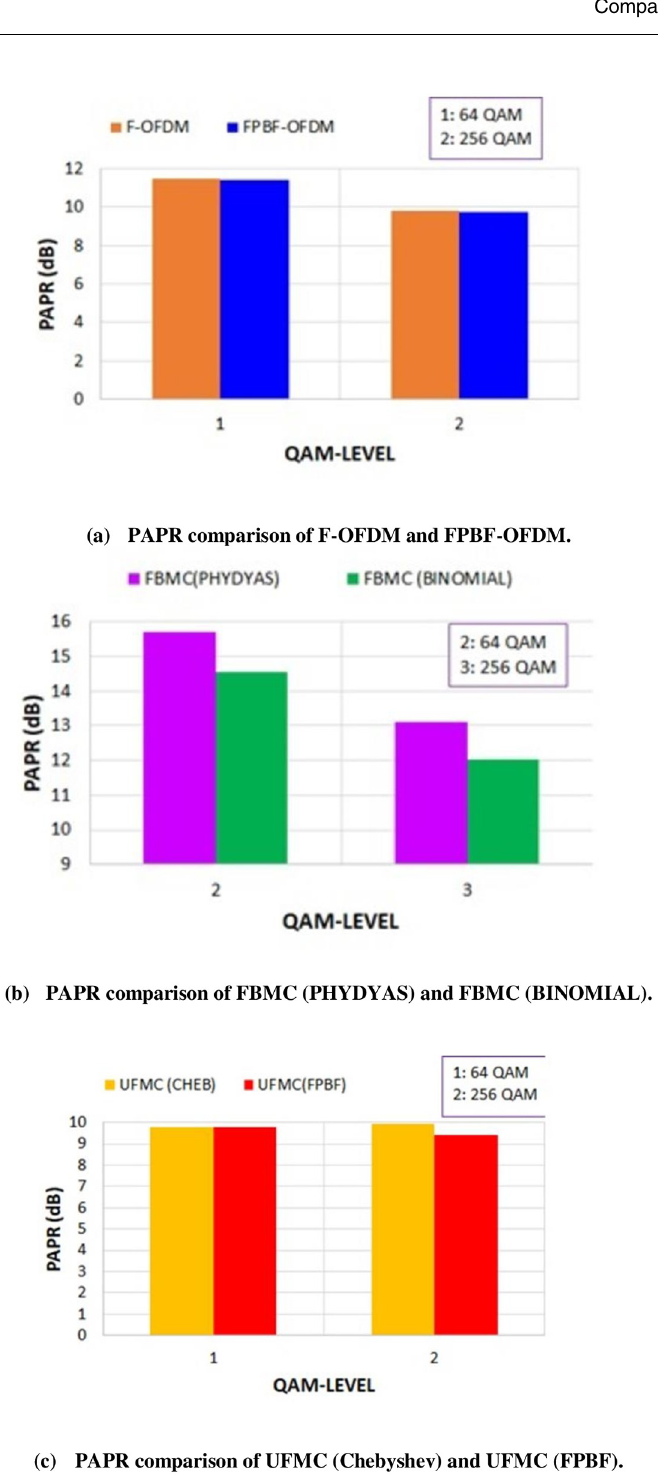
Fig 5. PAPR of different NR systems with different QAM levels. (a) PAPR comparison of F-OFDM and FPBF-OFDM. (b) PAPR comparison of FBMC (PHYDYAS) and FBMC (BINOMIAL). (c) PAPR comparison of UFMC (Chebyshev) and UFMC